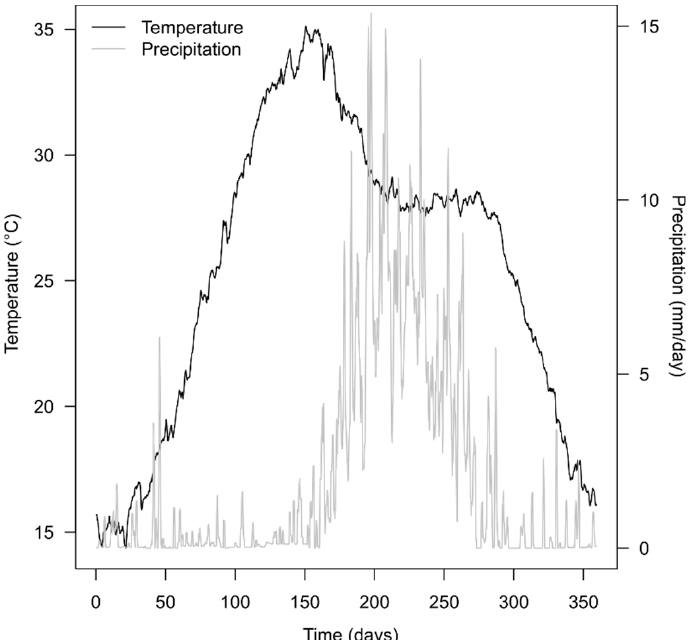
Figure 3. Daily average temperature and precipitation for the period 1979 to 2002, using WATCH climatology [57].